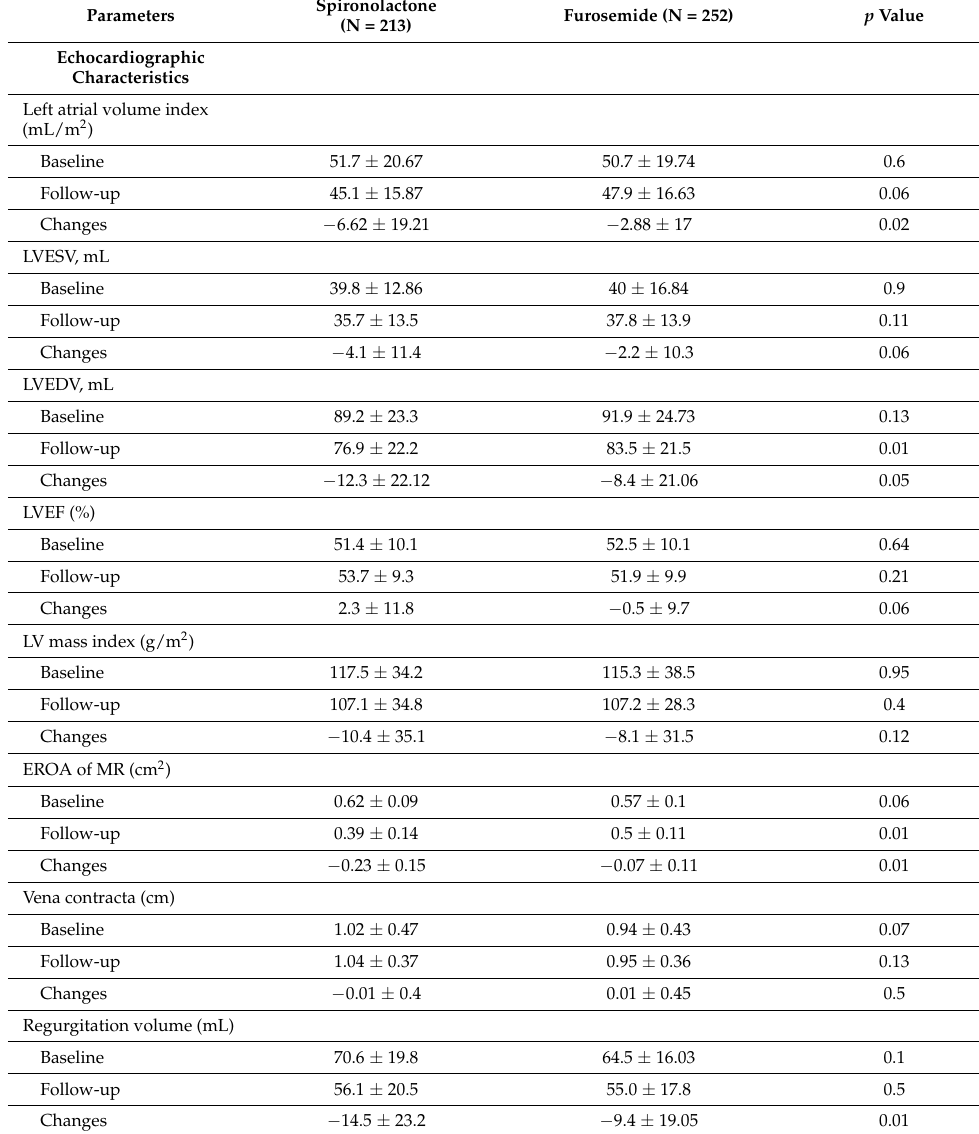
Table 2. The echocardiographic characteristics of patients with moderate/severe mitral regurgitation receiving either spironolactone or furosemide (N = 465). Parameters Spironolactone (N = 213) Furosemide (N = 252) p Value Echocardiographic